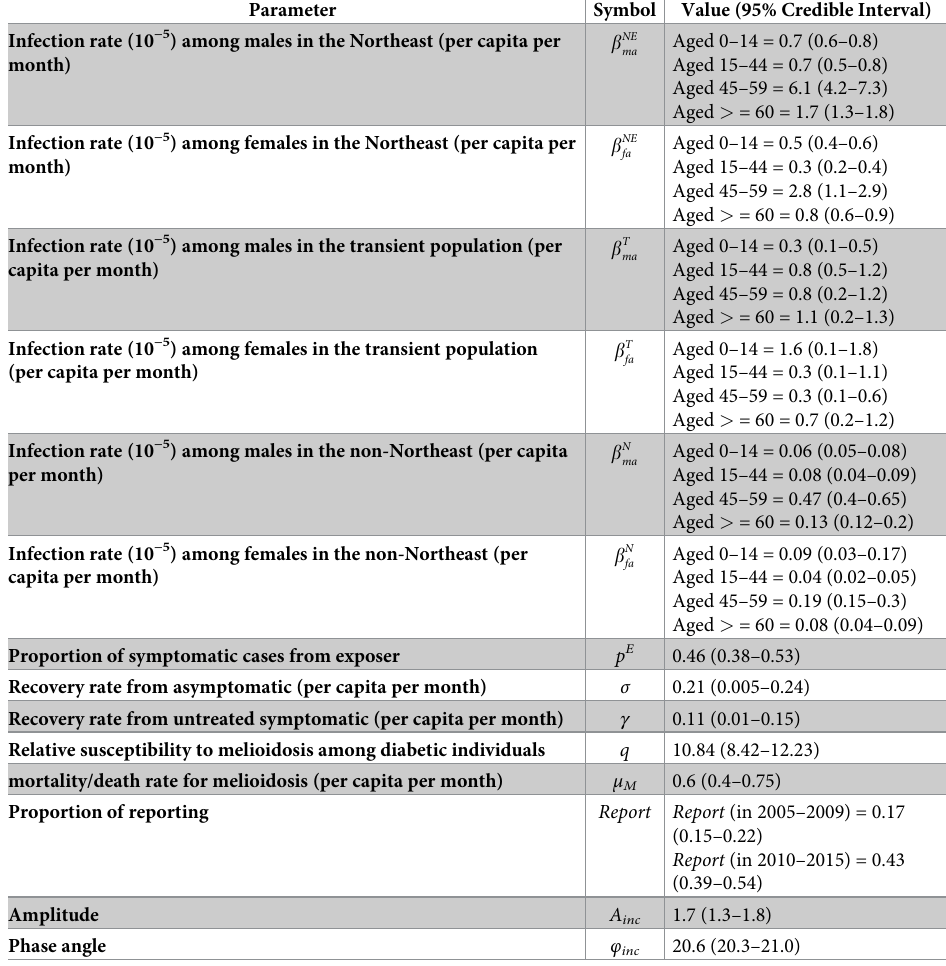
Table 1. Results of estimated parameters of the melioidosis model.